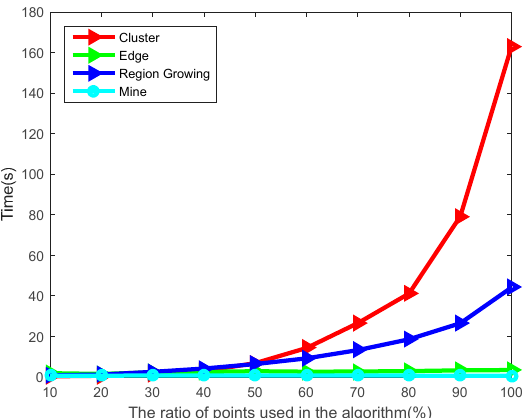
Figure 6. The time of different segmentation algorithms under different cloud numbers.